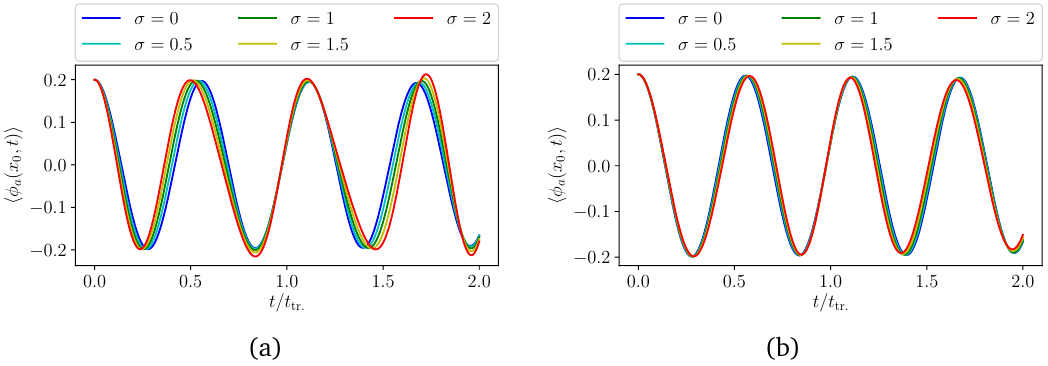
Figure 7: (a) The time and position dependence of 〈 φ same initial condition as Fig. 6(a) with σ = 2. We see that the initially flat profile develops inhomogeneities due to the sector coupling. (b) the same as panel (a), but ( x ) 〉 . showing 〈 Π a